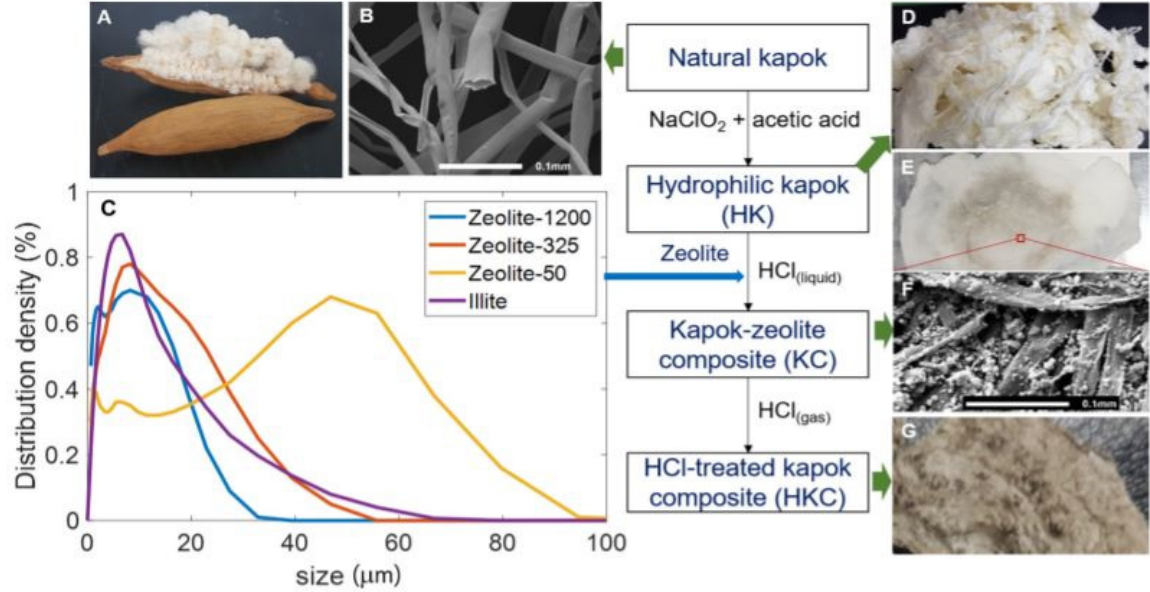
Figure 5. ( A ) Image. ( B ) SEM scans of natural kapok fibers. ( C ) Size dispersion of adsorbent particles as assessed by dynamic light scattering devices. ( D ) After hydrophilic pretreatment, kapok fiber becomes whiter and firmer. ( E ) A fine kapok layer surrounds the zeolite fragments, and ( F ) flattened kapok fibers are heaped without any gaps for the zeolite particles to fall through. ( G ) HCl-treated kapok fiber turns grey and gets thinner. Reprinted with permission from Ref. [76]. Copyright 2021, copyright Elsevier.